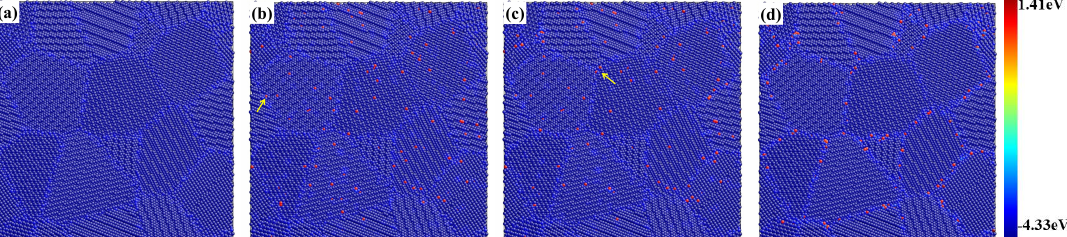
Figure 2. ( a ) Nanocrystalline model after energy minimization; ( b ) The model with BCC He (1%); ( c ) The model with uniform He (1%); ( d ) The model with GB He (1%). The atom in model ( a – d ) was colored according to potential energy (see color map). The red ball in ( b – d ) represents He